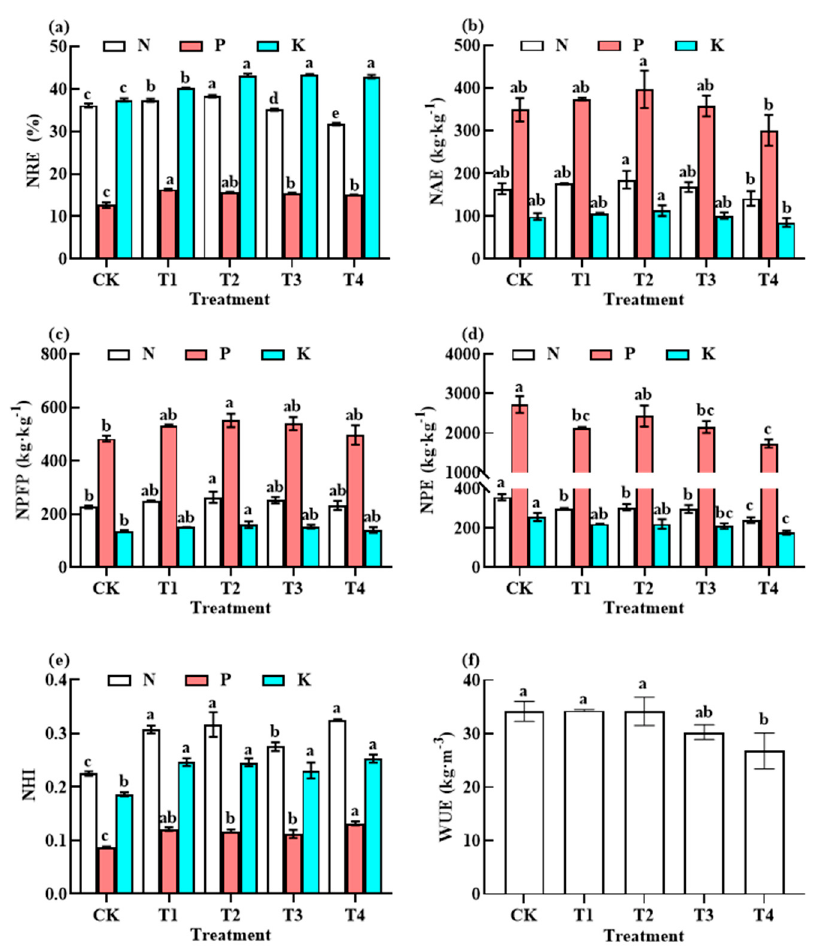
Figure 5. Effects of reduced fertiliser application before harvest on nutrient and water use efficiency. The amount of water irrigation and fertilisation throughout the experimental period was recorded to detect water use efficiency (WUE) and nutrient use efficiency. NAE, NRE, NPFP and NPE ( a – f ) represent the agronomic efficiency, recovery efficiency, partial-factor productivity and physiological efficiency for the applied nutrient (N, P and K), respectively. NHI represented the nutrient harvest index. Data were the means of three replicates with standard error ( ± SE). Different letters indicated significant differences between treatments at p of 0.05 according to Tukey’s multiple range test (n = 3). With no fertiliser reduction as the control (CK), the T1, T2, T3 and T4 treatments represented 20%, 40%, 60% and 80% reduction in fertiliser application from 0 to 6 days before each harvest,